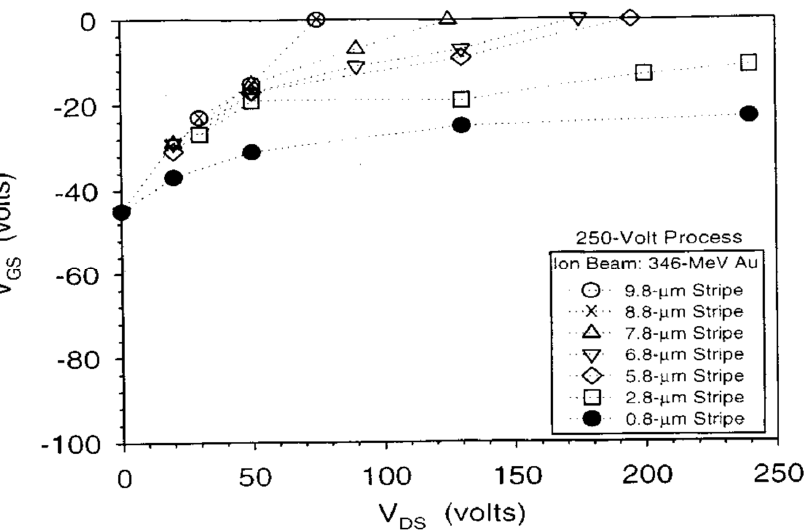
Figure 1. Single event gate rupture (SEGR) failure threshold responses for various L JFET , after Reference [10].